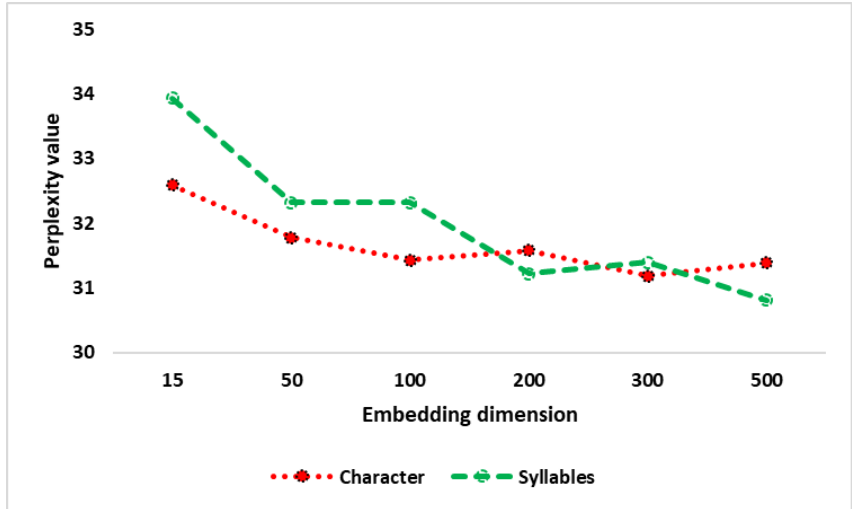
Figure 3. The effect of different character and syllable dimensions on perplexity values. The most appropriate dimension for our experiment is 200 or